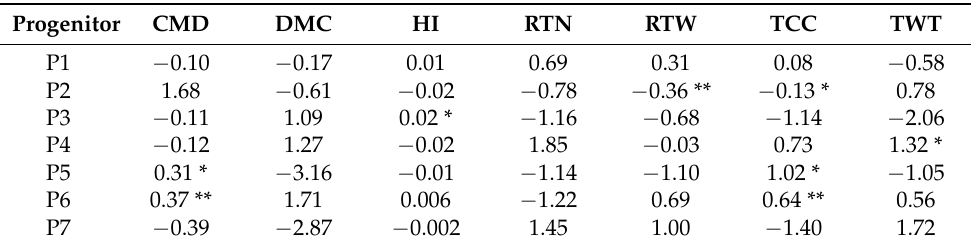
Table 4. General combining ability effects of cassava progenitors for seven traits at two locations in